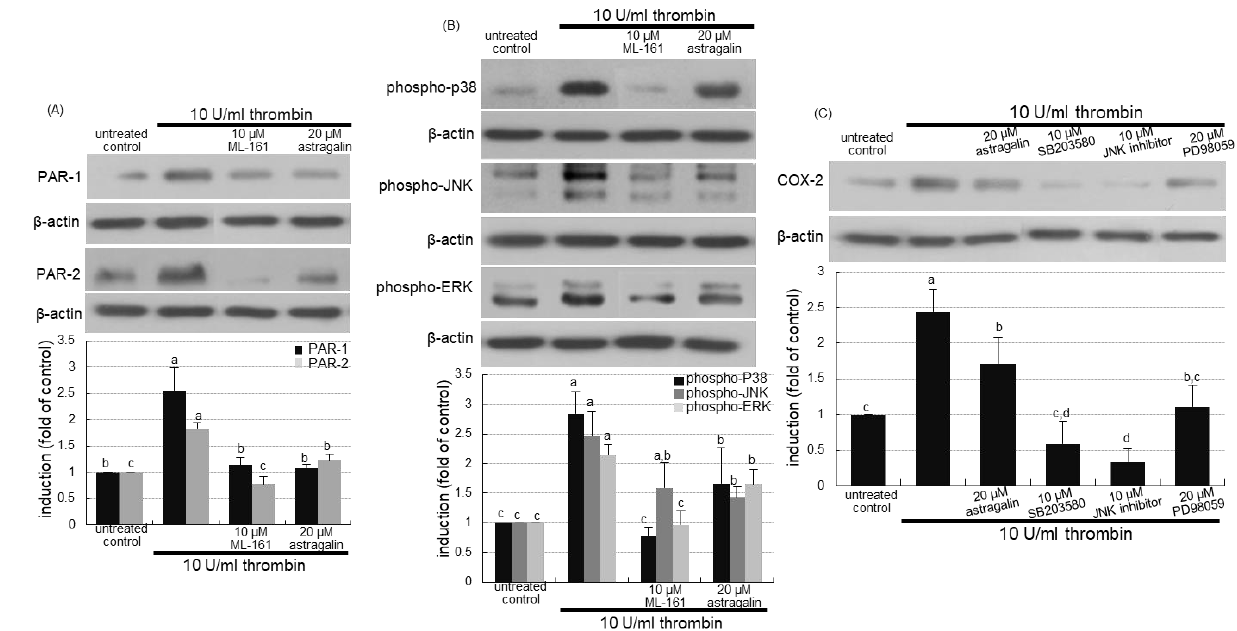
Figure 7. Inhibition of activation mitogen-activated protein kinase (MAPK) by protease-activated receptor (PAR) inhibitor ( A , B ), and cyclooxygenase (COX)-2 inhibition by MAPK inhibitors ( C ) in thrombin-treated A549 cells. Alveolar epithelial cells were incubated in media containing 10 U/mL thrombin in the presence of 10 µ M ML-161, 20 µ M astragalin, or 10–20 µ M MAPK inhibitors for up to 72 h. Cell lysates were subject to Western blot analysis with a primary antibody against PAR-1, PAR-2, phospho-p38, phospho-c-Jun N-terminal kinase (JNK), phospho-extracellular signal-regulated kinases (ERK) or COX-2. β -Actin protein was used as an internal control. The bar graphs (mean ± SEM, n = 3) represent quantitative results of the upper bands obtained from a densitometer. Values in bar graphs (same achromatic colored) not sharing the same lower case alphabet letter indicate a significant difference at p < 0.05.